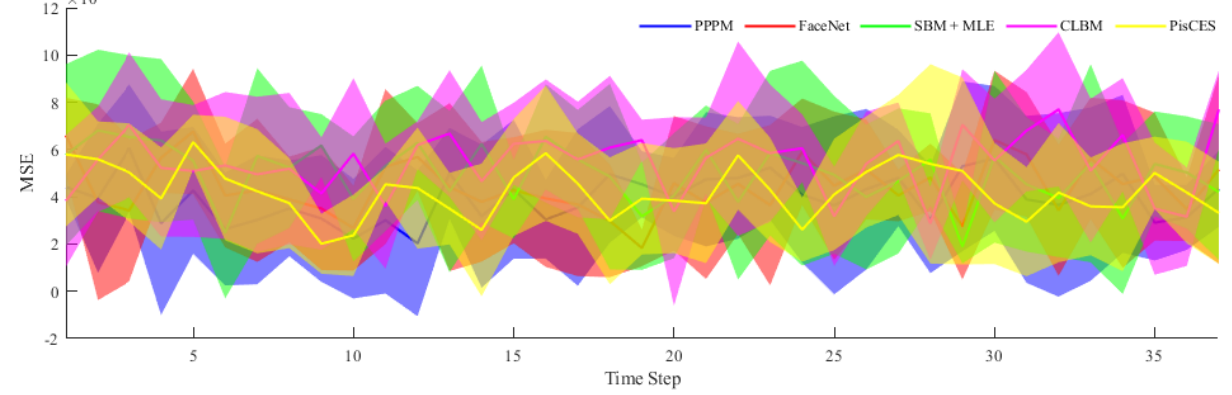
Figure 6. Comparison of the proposed method with 4 different models on MSE (synthetic network).